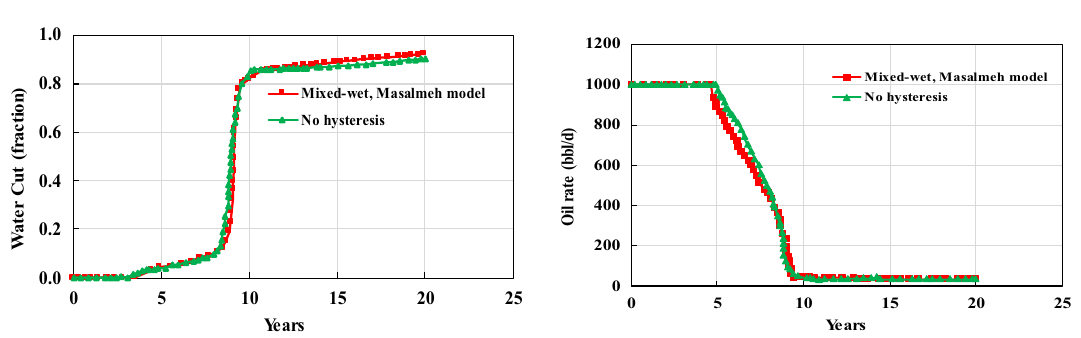
Fig. 21 Comparison of water cut and oil rate for different simulation runs with and without